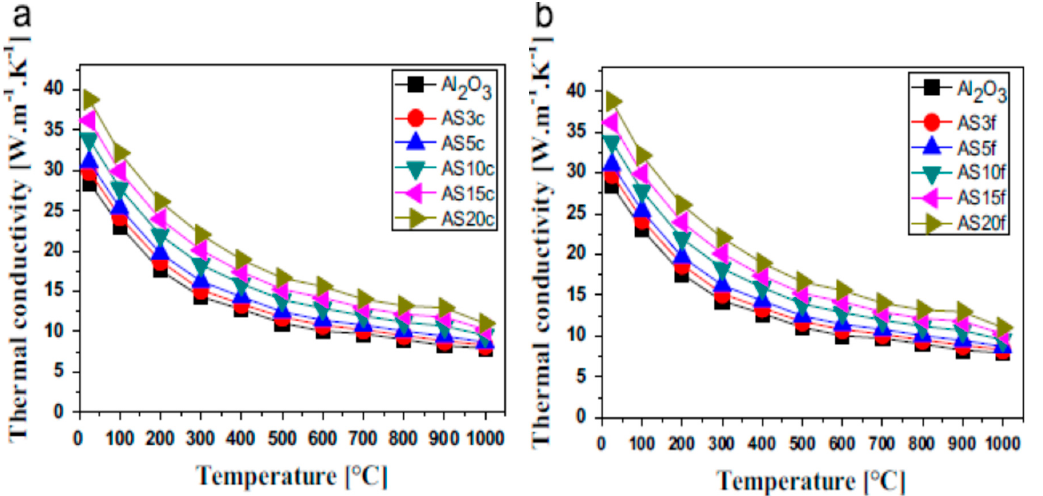
Figure 10. Thermal conductivity vs measurement temperature: ( a ) nanocomposites AS X c ; ( b ) nanocomposites AS X f. (f = fine, c = coarse). Reproduced with permission from [85]. Copyright Elsevier, 2014.